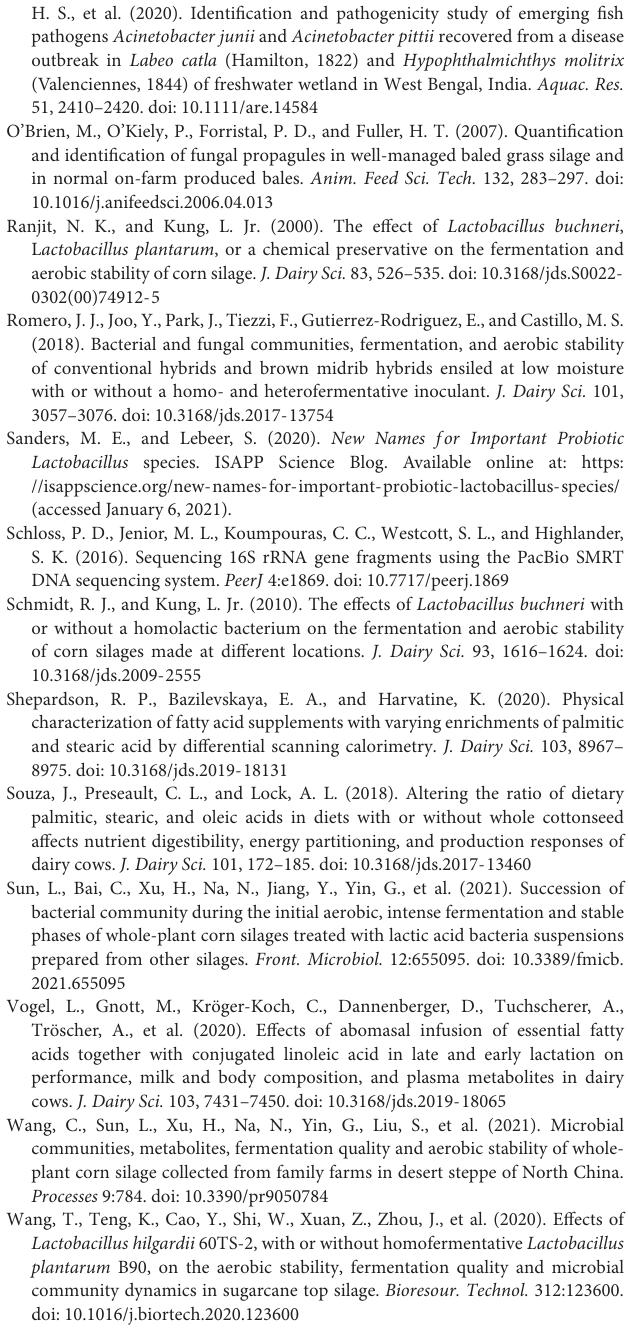
Supplementary Table 2 | Relative concentration of metabolites detected in whole-plant corn silages. H, ensiled whole corn plants with a high moisture content (680 g/kg) harvested at the one-third milk-line stage; L, ensiled whole corn plants with a low moisture content (620 g/kg) harvested at the two-thirds milk-line stage. Supplementary Table 3 | Different identified metabolites between H0 and L0 (A) , H2 and L2 (B) , and H5 and L5 (C) correlation between the degree of silage temperature above ambient temperature (DSTAT) and the identified metabolites